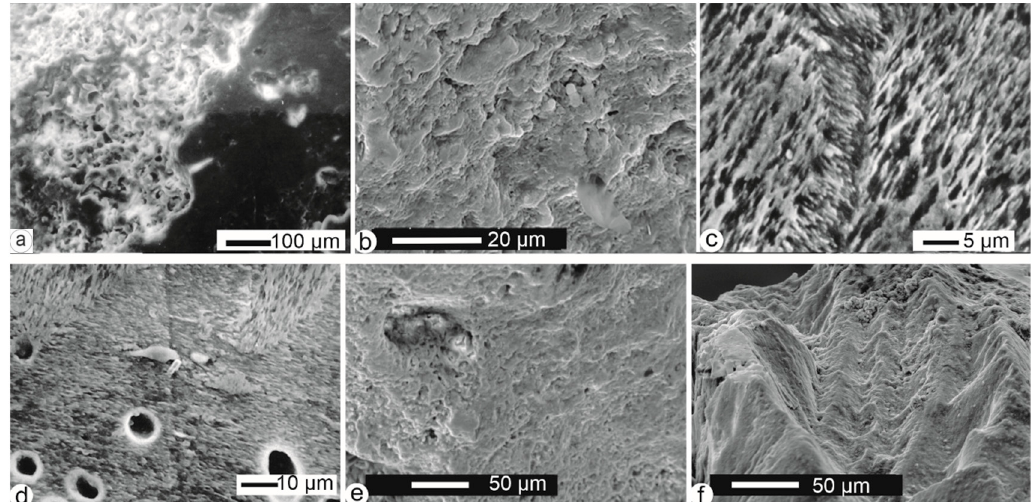
Figure 7. Fossil bones from Mwenirondo. ( a ) Detail of the surface of vertebra shown in Figure 6c with polished and eroded zones. ( b ) Fractured long bone: the outer layers have been destroyed and the structure of the bone is not preserved; cleaned using an ultrasonic bath and H 2 O. ( c ) Polished and etched surface of a large vertebra showing the preserved inner structure. ( d ) Holes in the sample shown in Figure 7c. ( e ) Small holes on the altered articular zone of the sample shown in Figure 7b. ( f ) Fracture of the sample of Figure 7b, showing the strongly modified bone structure.